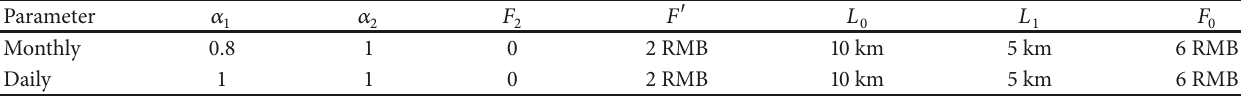
Table 1: Parameter values used to determine the monthly and daily travel expenses for CB services in Dalian. Parameter 𝛼